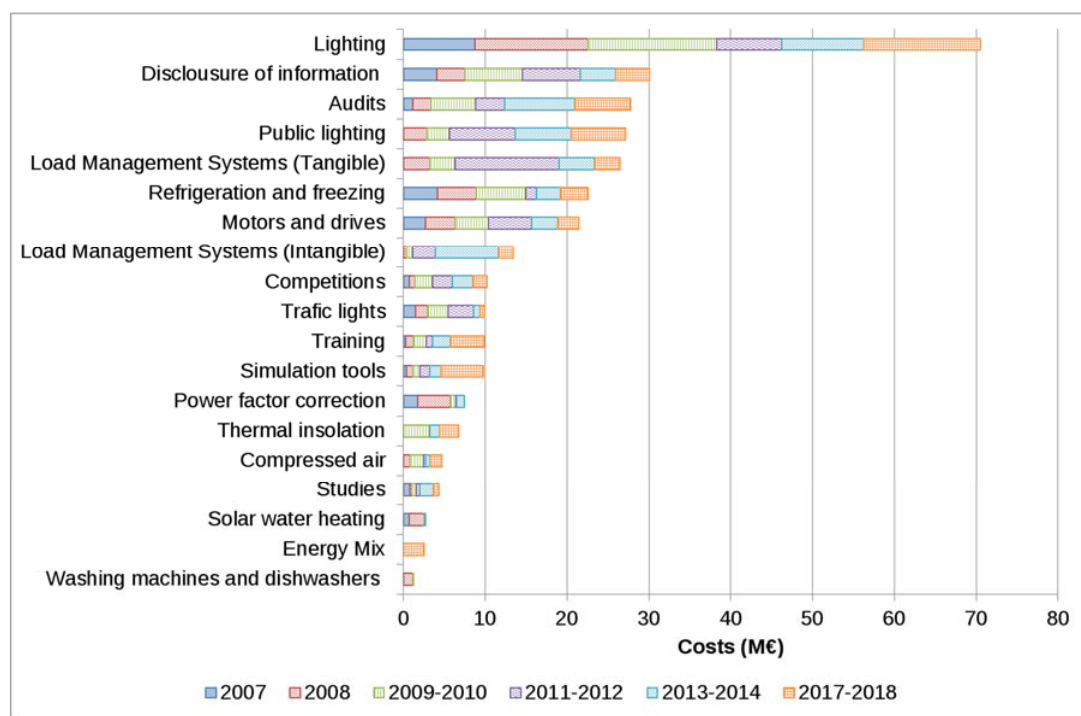
Figure 13. Costs of the measures by targeted energy services, for each PPEC edition [19–25].